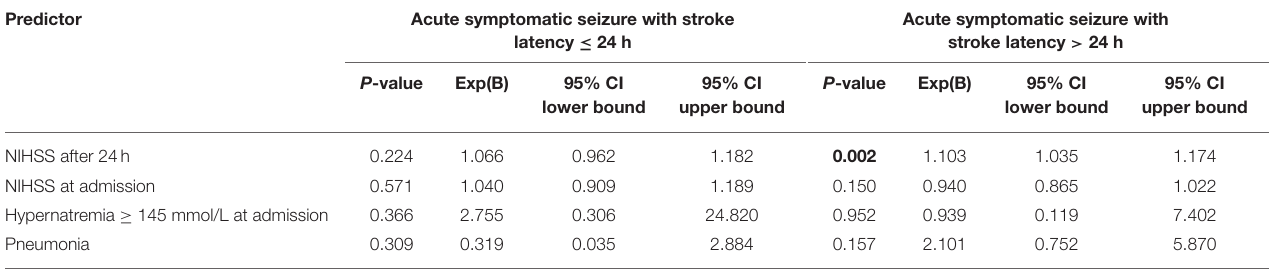
TABLE 3 | Multiple logistic regression analysis with subgroups of seizure patients. Predictor